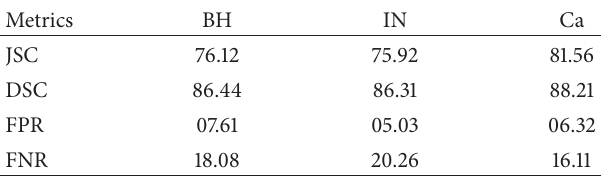
Table 1: Average performance metrics (%) of three cancer cell types.